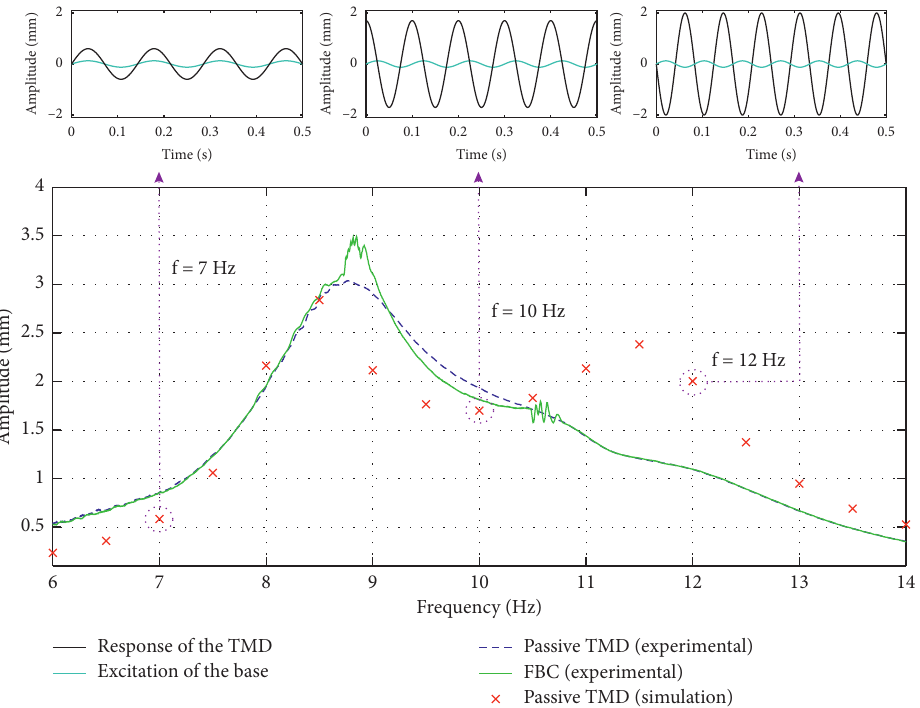
Figure 10: Frequency domain analysis of the TMD amplitude.